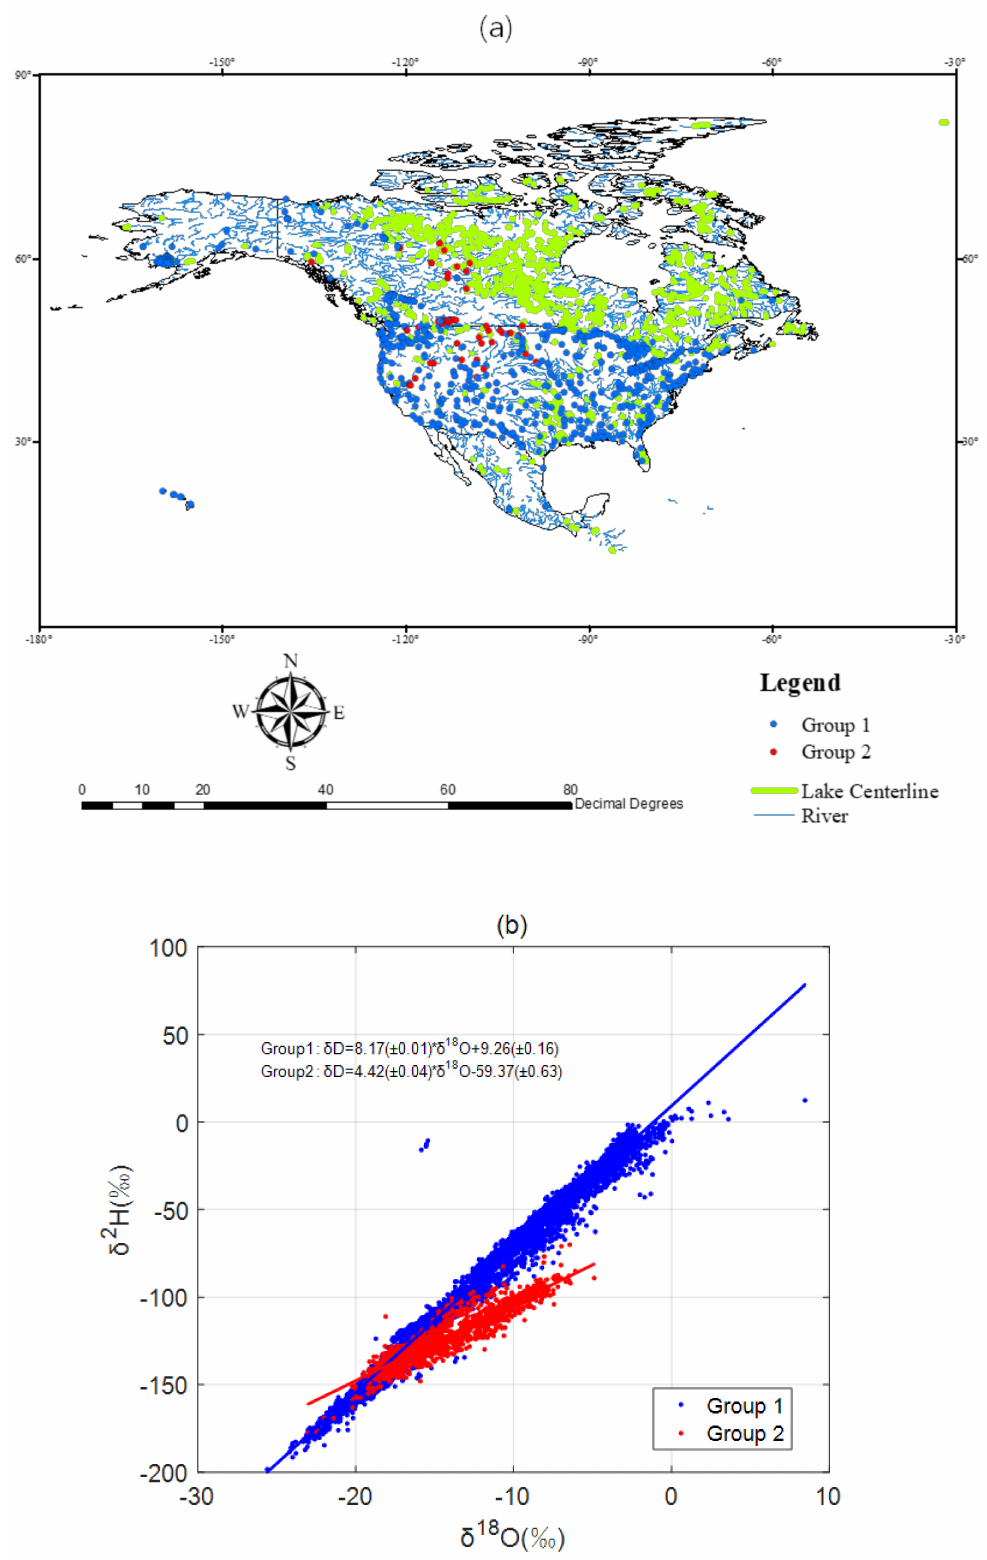
Figure 12. Group of isotopic data in North America. ( a ) Location of data points in North America. ( b ) 2 H- δ 18 O relationship in North America. Blue and red points stand for data points with high and low slopes, respectively. Blue and green lines in the map are the major rivers and lake centerlines in North America, respectively